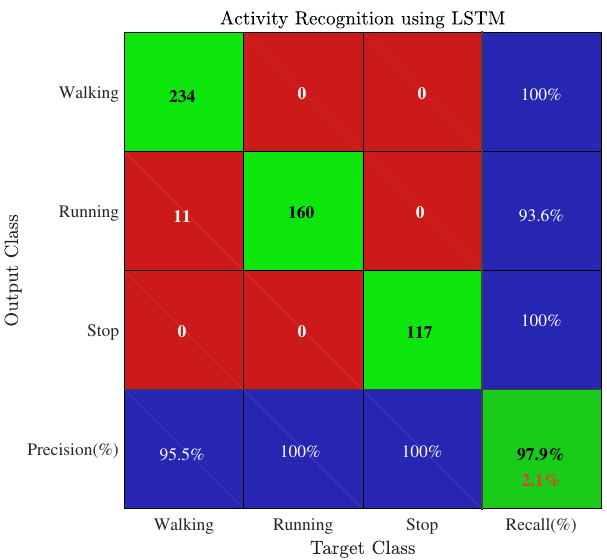
Figure 11. Confusion matrix representing the performance of LSTM for activity recognition (test accuracy).